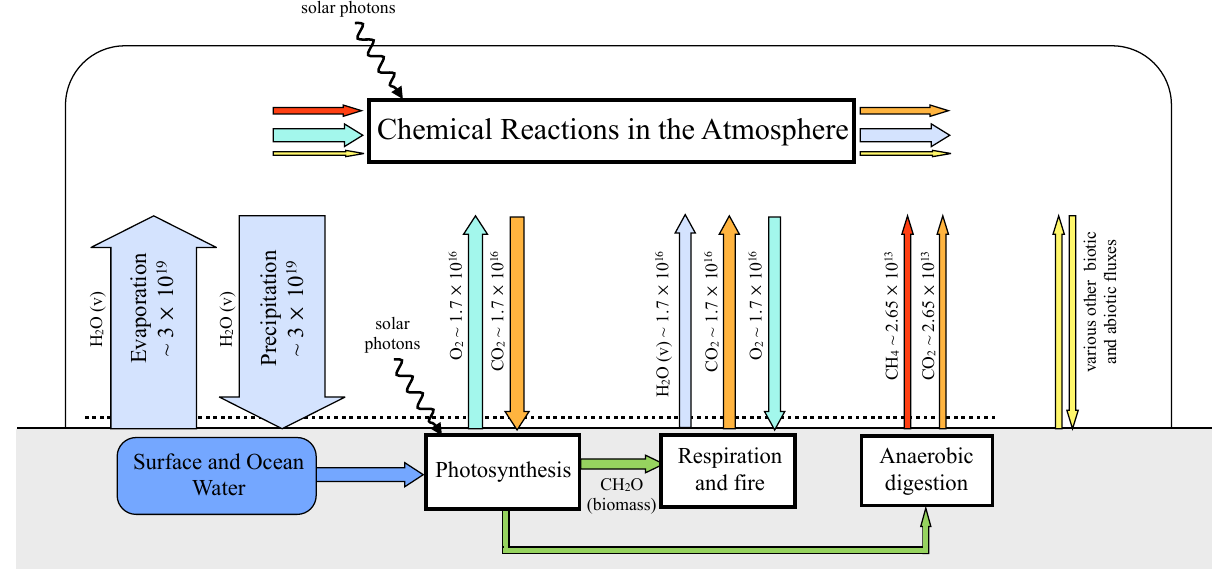
Fig. 4. A graphical illustration of the fluxes of various gases in and out of the atmosphere. All figures are taken from Schlesinger (1997), updated with Ehhalt et al. (2001) and EPA (2010), and have been converted to mola − 1 . There is a large amount of uncertainty in these figures; in particular, the uncertainty in the methane fluxes is of the order of 10%. The largest fluxes are associated with the water cycle; evaporation adds H 2 O( v ) to the atmosphere at a rate of around 3 × 10 19 mola − 1 , which is almost exactly balanced by its removal due to precipitation. Much smaller fluxes of O 2 and CO 2 are produced by photosynthesis, which also requires liquid water and a power source, in the form of sunlight. These fluxes are almost balanced by respiration and fire, with only a small fraction of biomass being consumed by anaerobic digestion, which adds CH 4 and CO 2 to the atmosphere at a rate of the order 3.5 × 10 13 mola − 1 , of which around 1.2 × 10 13 mola − 1 is from natural sources and the rest is anthropogenic. Abiotic sources, primarily fossil fuel burning, add an additional 8 × 10 12 mola − 1 of methane to the atmosphere. The influx of methane is balanced by a complex network of chemical reactions in the atmosphere, one of whose net effects is to convert CH 4 and O 2 into CO 2 and H 2 O. The thick dotted line indicates which fluxes are included in our analysis. We calculate the net fluxes of energy and entropy passing through this surface, excluding the radiative